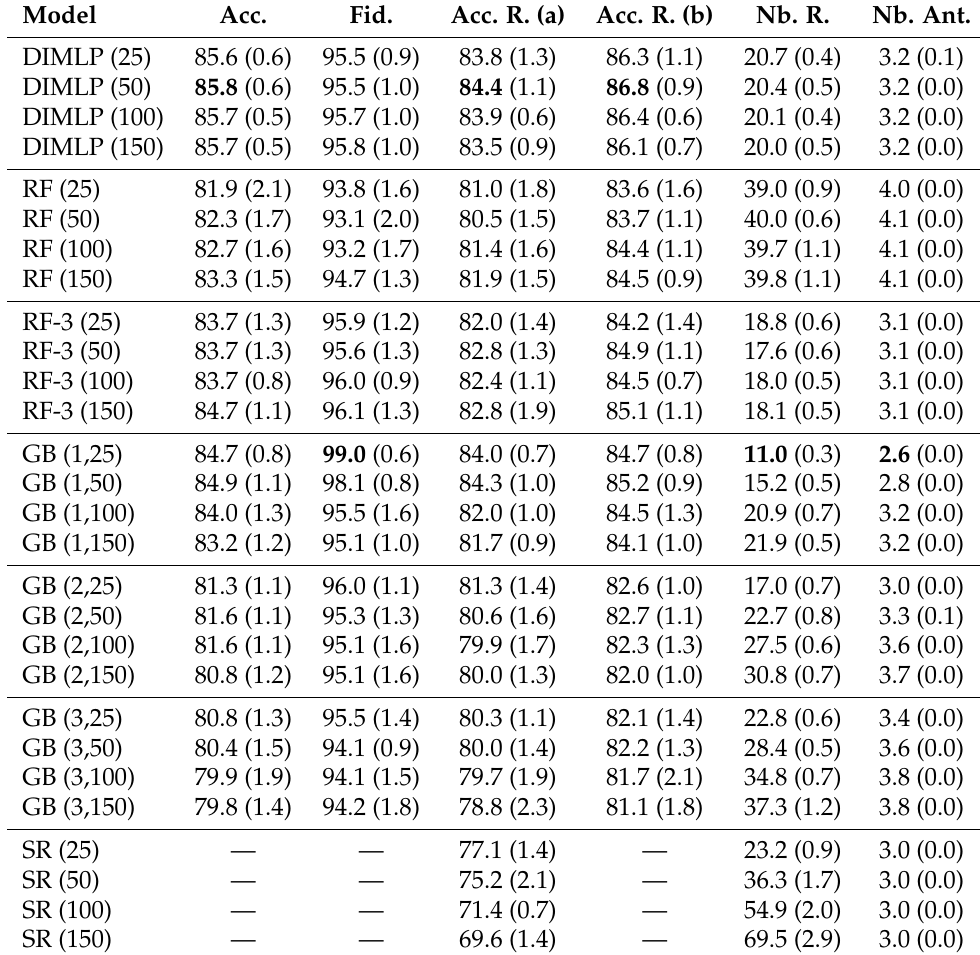
Table 5. Average results obtained on the “Heart Disease” dataset. For each column, the highest average accuracy or average fidelity is represented in bold, along with the lowest average number of rules or average number of